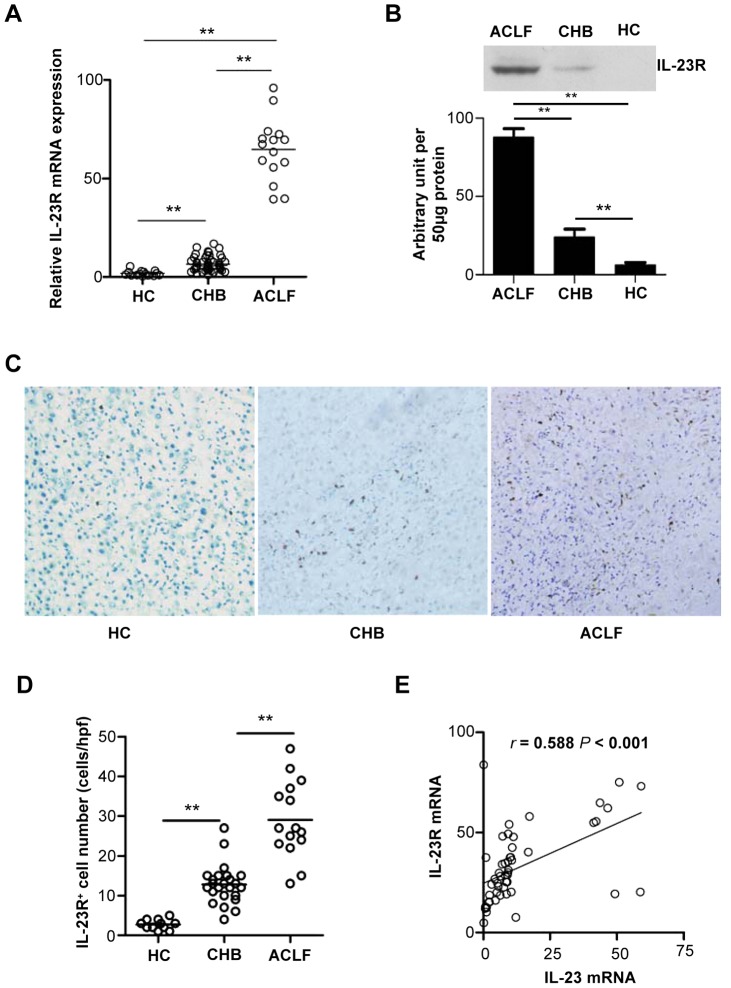
IL-23R expression is enhanced markedly and correlated with IL-23 level in liver tissues of CHB and ACLF patients.(A) Relative mRNA expression of IL-23R in liver tissue of various groups was analyzed by qRT-PCR. (B) Protein expression of IL-23R was analyzed by Western blot. Error bars indicate SD. **P<0.01. (C) In situ expression of IL-23R in liver tissues was detected by immunohistochemical staining (magnification 100×). (D) The frequencies of intrahepatic IL-23R positive cells in patients with hepatitis B and health controls are shown. Error bars indicate SD. **P<0.01; HPF, high power fields. (E) The correlation was analyzed between the expression of IL-23 and IL-23R in HBV infected liver tissue. r is the correlation coefficient and P-value is shown.